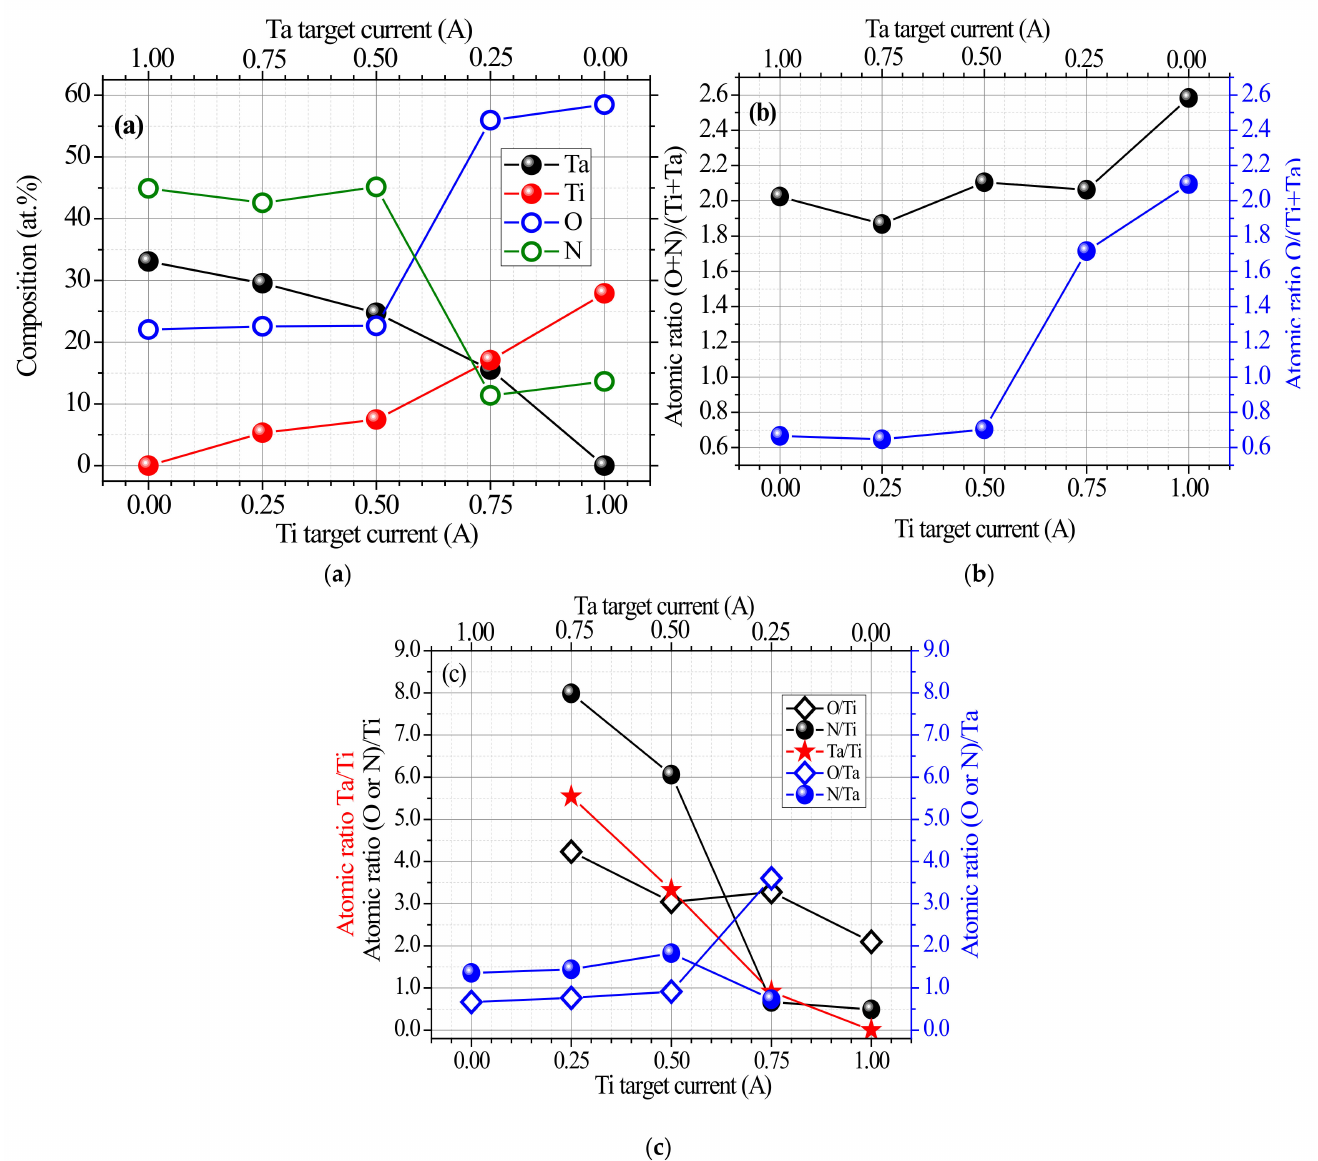
Figure 2. Chemical composition ( a ) and atomic ratios ( b ) and ( c ), as a function of Ti and Ta target applied